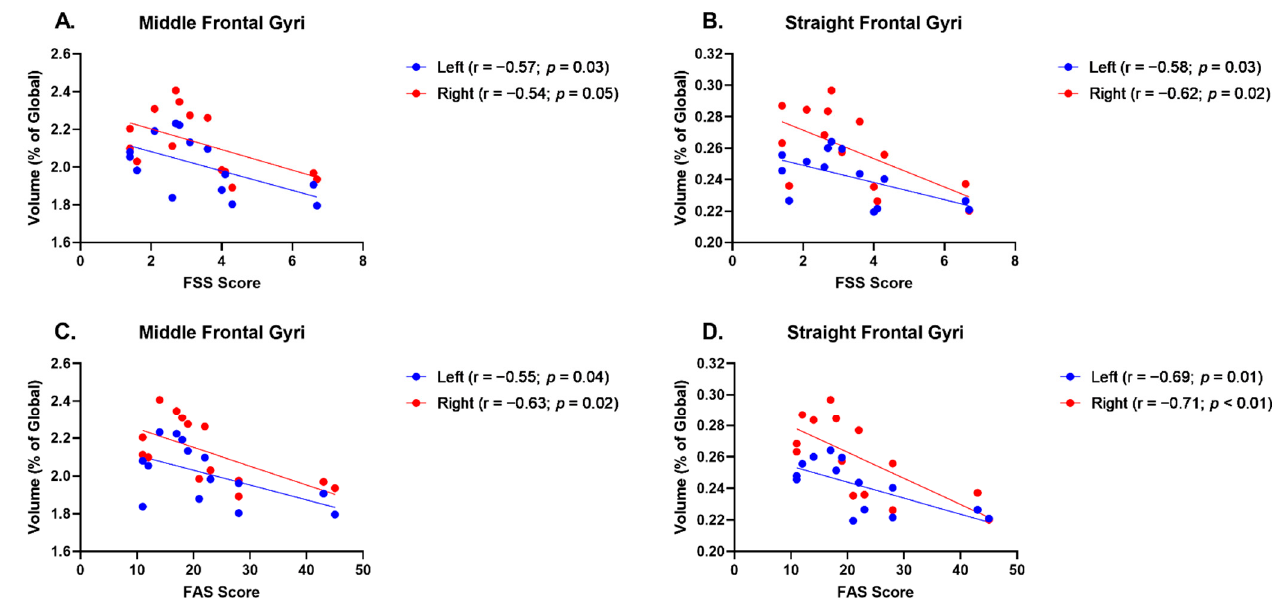
Figure 3. Pearson’s correlations for FSS ( A , B ) or FAS ( C , D ) and RRV in the middle and straight frontal gyri in subjects > 6 months post-infection. In all cases, a smaller RRV was associated with worse fatigue (FSS) and perceived fatigability (FAS).